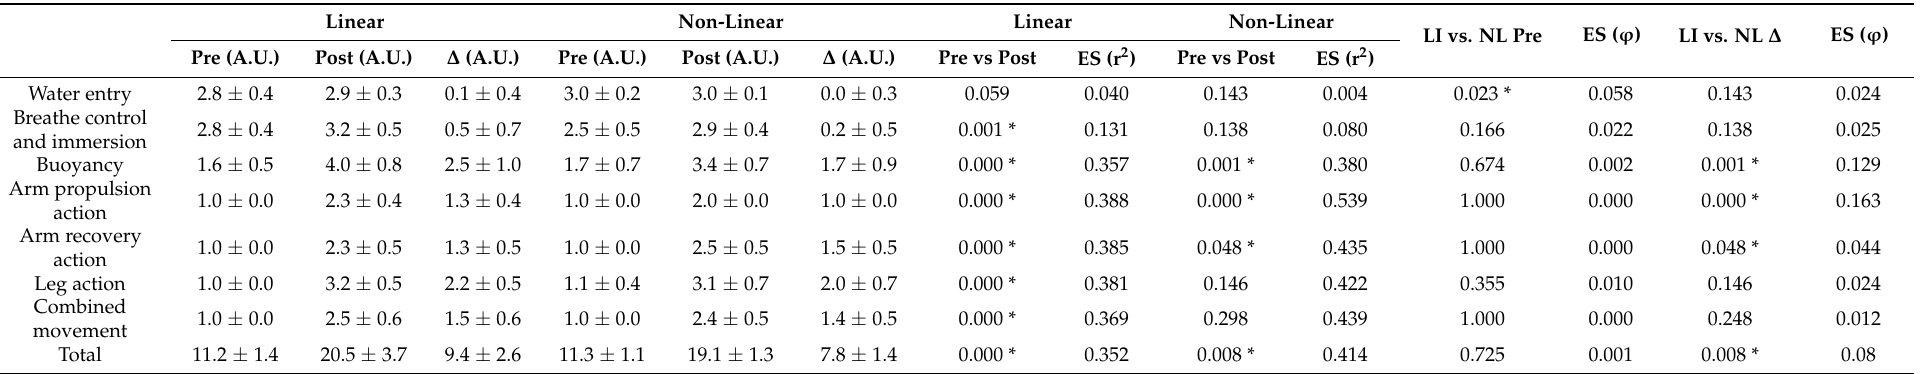
Table 2. Results of Pre and Post Langerdofer-Bruya aquatic motor competence tests, expressed as mean ± standard deviation. Statistical differences ( p < 0.05) of intra-group analysis are reported in Pre vs. Post columns. Statistical differences ( p < 0.05) of inter-group analysis are reported “LI vs. NL pre” and “LI vs. NL ∆ ” columns. ES = effect size. * p < 0.05.